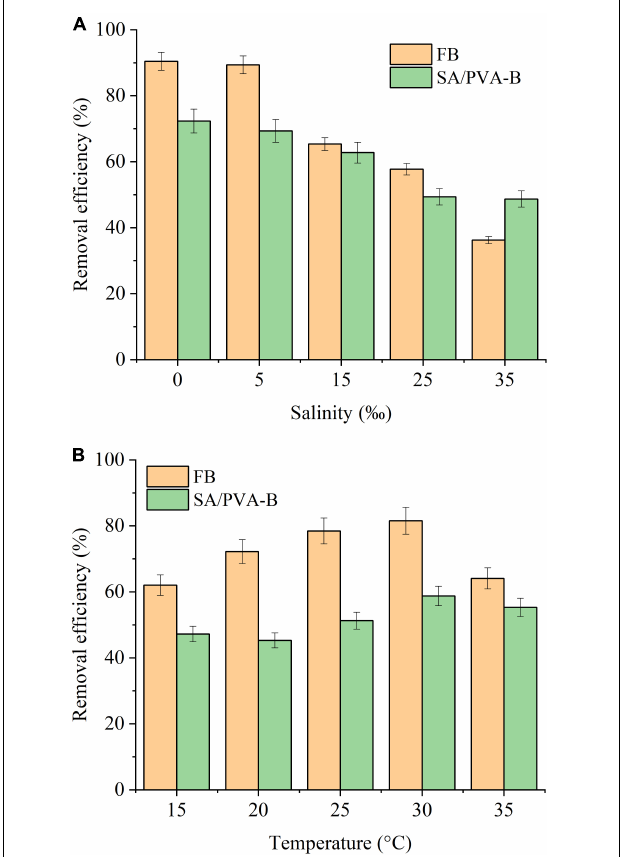
FIGURE 6 | Effects of (A) salinity and (B) temperature on different immobilized biomaterials. FB, free Ochrobactrum sp. without any immobilization methods; SA/PVA-B, SA and PVA as base material to immobilize Ochrobactrum sp.